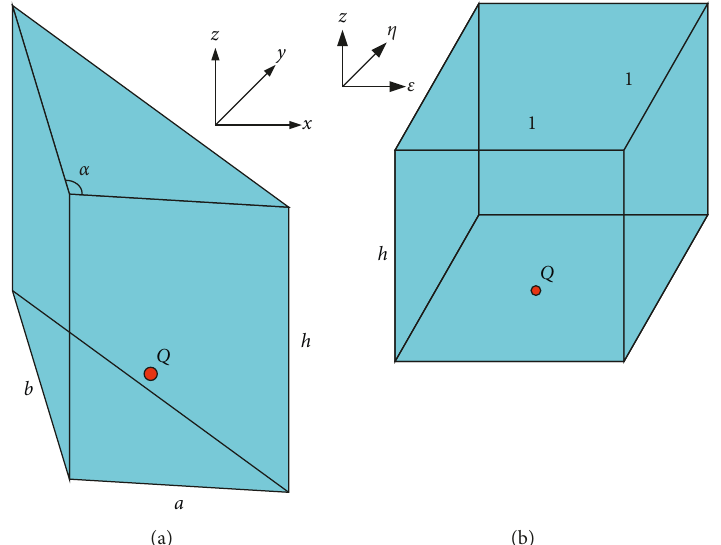
Figure 1: Arbitrary triangular prism acoustic cavity model and coordinate transformation. (a) The original coordinate system. (b) The new coordinate system.